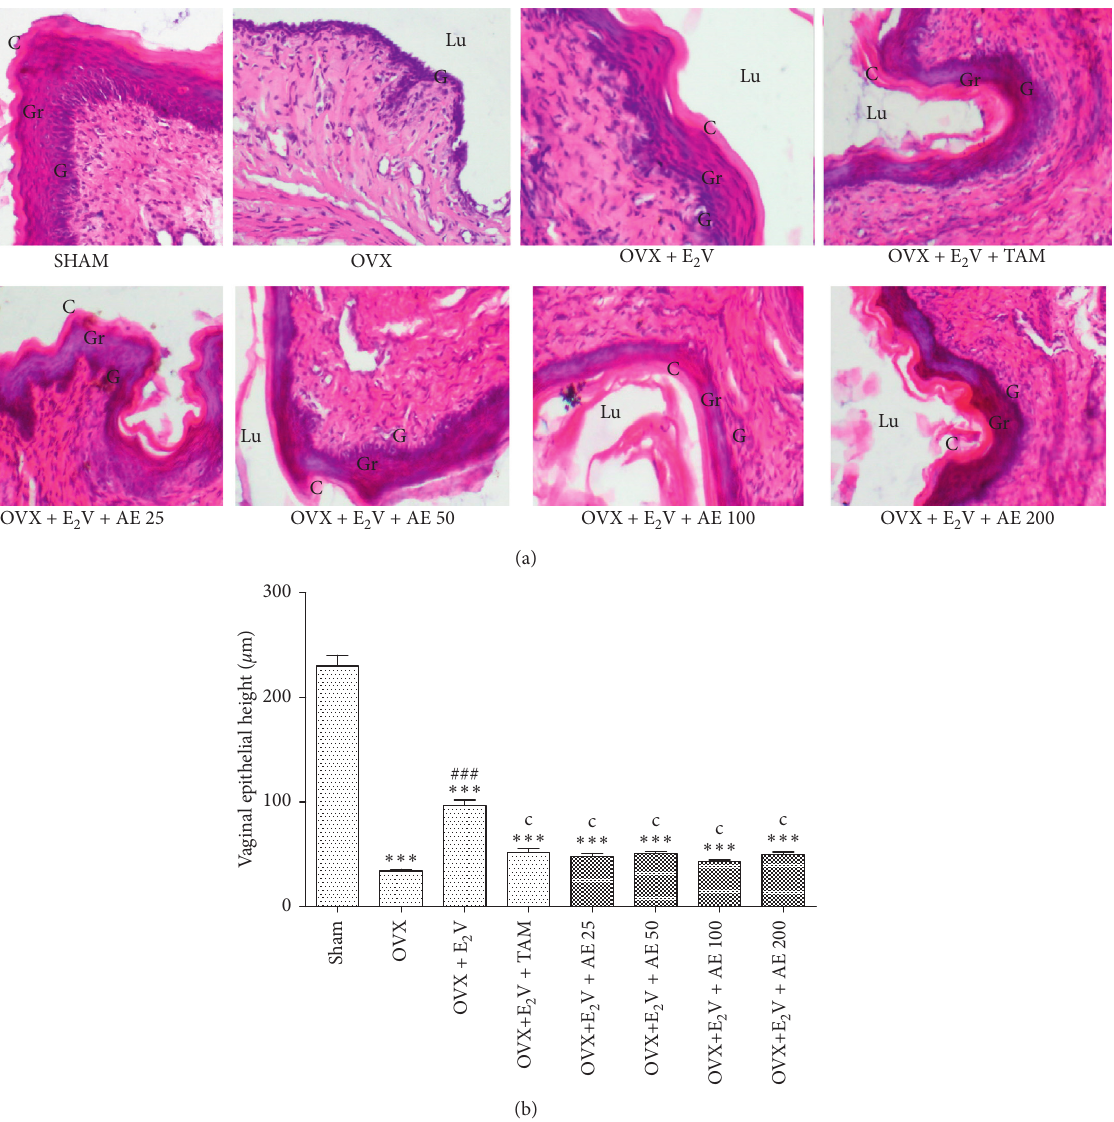
Figure 5: Microphotographs (H&E 400x) (a) and epithelial height (b) of the vagina after 3 days of treatment. SHAM: sham-operated animals; OVX: ovariectomized animals; E 2 V: estradiol valerate; TAM: tamoxifen; AE: aqueous extract of D. edulis leaves. Data from Figure 5(b) are presented as mean ± S.E.M. ( n � 6). ∗∗∗ p < 0 . 001 compared with SHAM; ### p < 0 . 001 compared with OVX; and C p < 0 . 001 compared with OVX +E 2 V. Lu: lumen; G: stratum germinativum; Gr: stratum granulosum; C: stratum